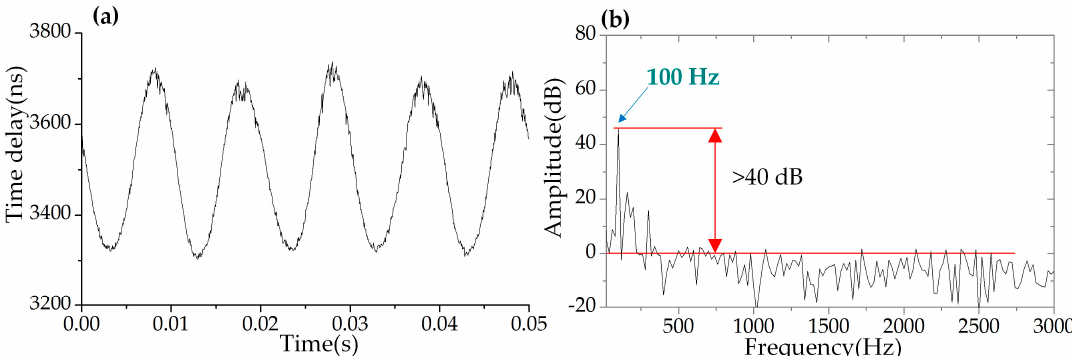
Figure 10. The driven signal applied to the piezoelectric transducer (PZT) stage. ( a ) The waveform in time domain. ( b ) The power spectral density of the FFT spectrum of (a).